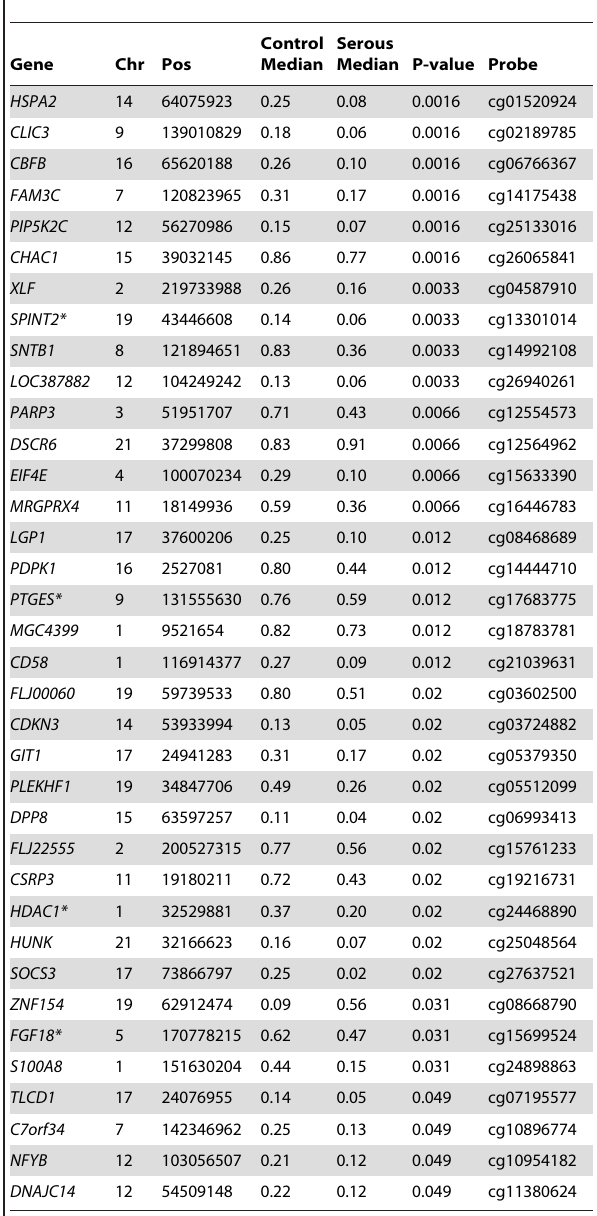
Table 2. Differential methylation of genes in supervised analysis, p ,